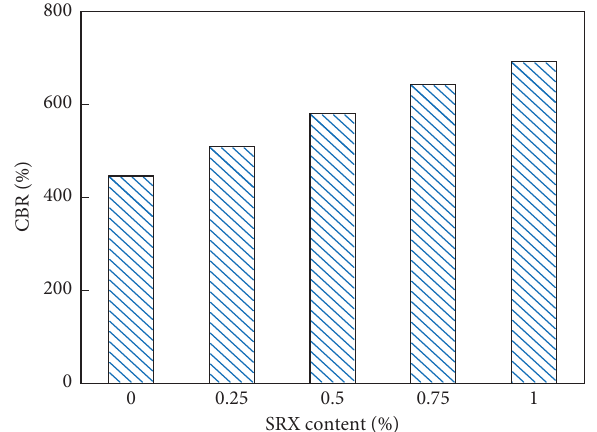
Figure 12: Change law of CBR with SRX